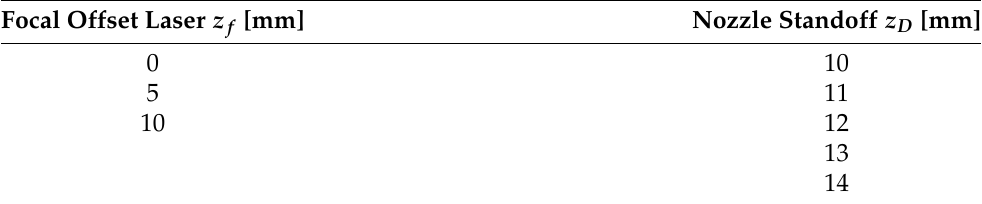
Table A5. Full-factorial design to study the interdependencies of linear energy input and mass